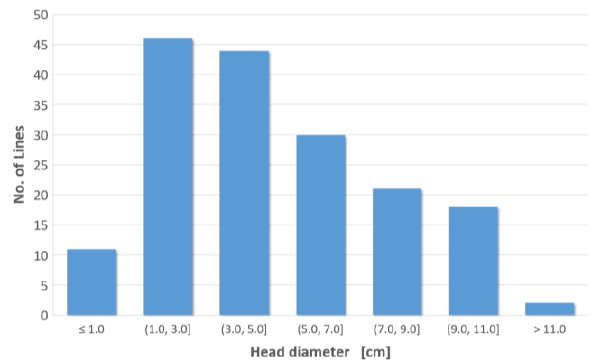
Figure 2: Diameter of cauliflower heads measured at 07-04-2016, N=174 Lines